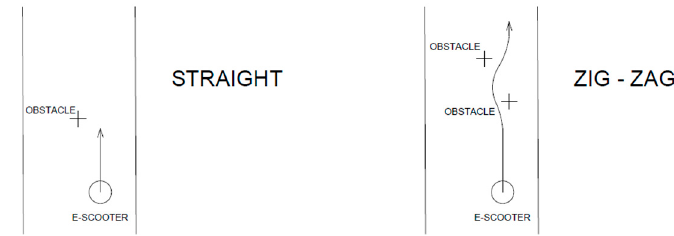
Figure 4. Different types of driver behaviour considered.